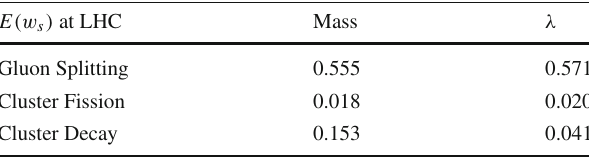
Table 6 Expected value of strangeness production weight of our new model in LHC Minimum Bias events at 7 TeV, comparing the total invariant mass results with the λ measure